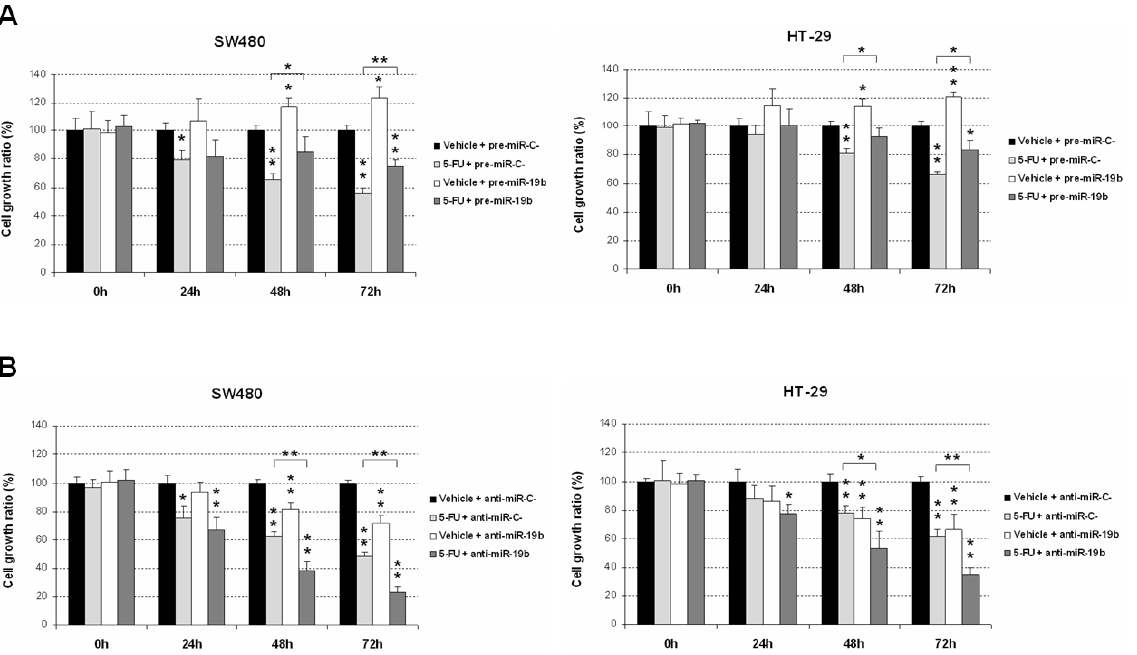
Figure 1. Changes in miR-19b expression results in altered sensibility to 5-FU treatment. MTS assay showing cell viability of SW480 and HT-29 cells treated with 5- FU (1μM) and transfected with ( A ) pre-miR-19b or ( B ) anti-miR-19b; * p < 0.05; ** p < 0.01. Asterisks over the columns refer to the comparison of each condition against the control (first column).